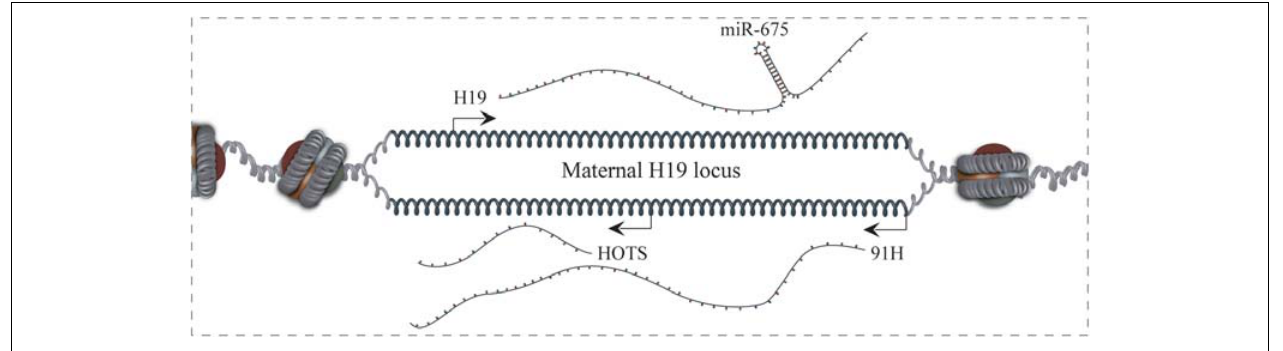
FIGURE 1 | Genomic organization of the maternal H19 locus. H19, H19 opposite tumor suppressor (HOTS), miR-675, and 91H are expressed from the H19/IGF2 locus. HOTS is a protein coding gene transcribed antisense to